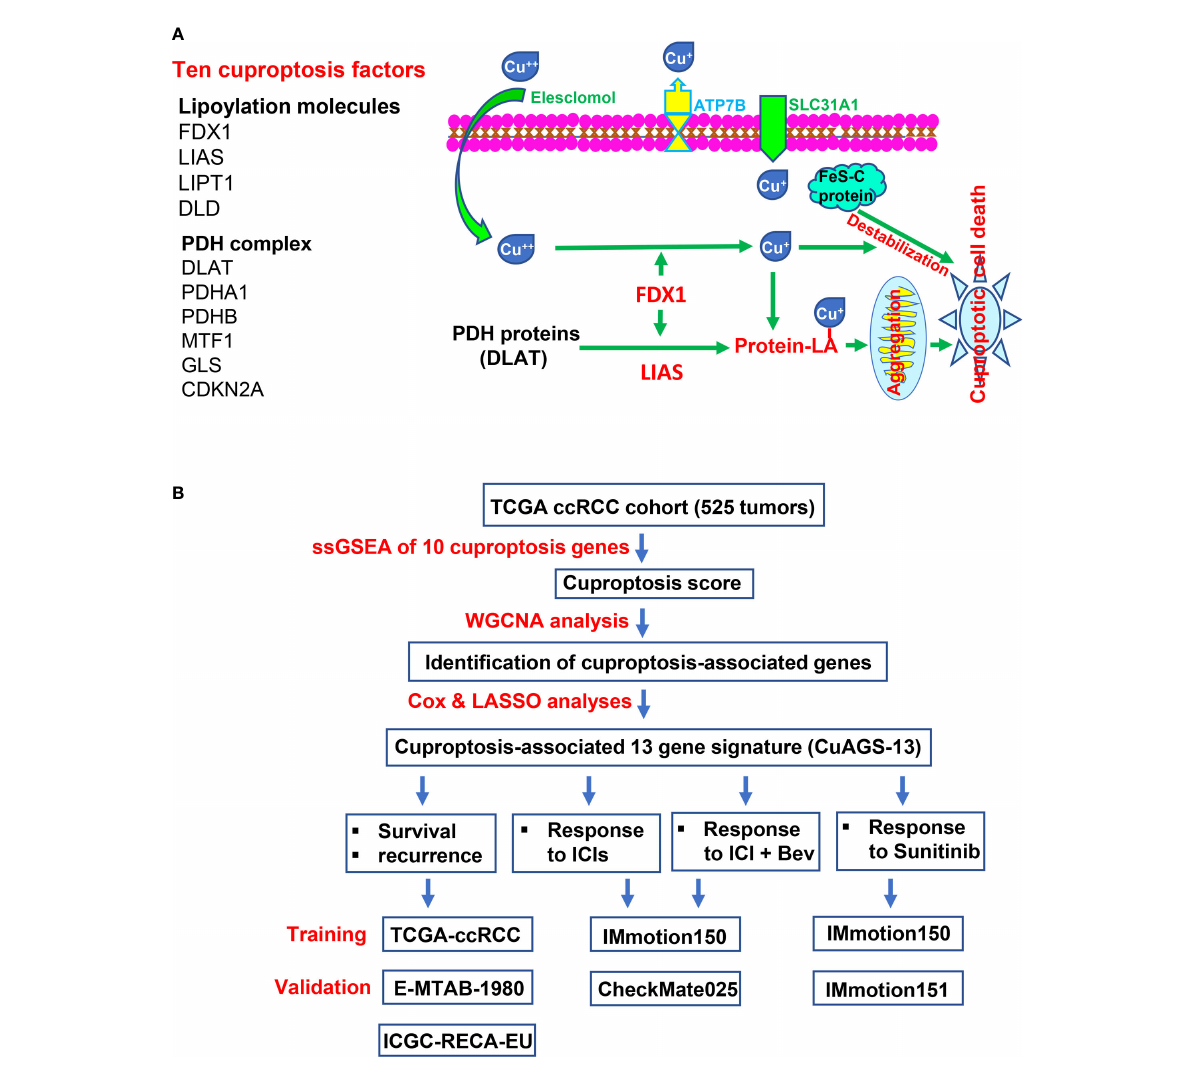
FIGURE 1 The Cuproptosis pathway and study work fl ow. (A) Left panel: Ten factors involved in cuproptosis. Right panel: The cuproptosis signaling pathway. Extracellular copper Cu ++ enters cells by binding to copper chelators and elesclomol serves as the most ef fi cient Cu ++ transporter. The reductase FDX1 reduces Cu ++ to Cu + , a more toxic form, while lipoyl synthase (LIAS) catalyzes lipoylation of the pyruvate dehydrogenase (PDH) complex proteins including dihydrolipoamide S-acetyltransferase (DLAT) and others. Cu + and lipoylation promote the protein aggregation. DLAT is one of the key enzymes participating in the tricarboxylic acid cycle, and its aggregation results in mitochondrial proteotoxic stress and subsequent cuproptotic cell death. Moreover, FDX1 and Cu + induce the destabilization of Fe – S cluster proteins, further facilitating cuproptosis. Additionally, SLC31A1 and ATP7B function as the Cu + importer and exporter, respectively, and regulate cuproptosis by controlling intracellular Cu + concentrations. (B) The schematic work fl ow of the present